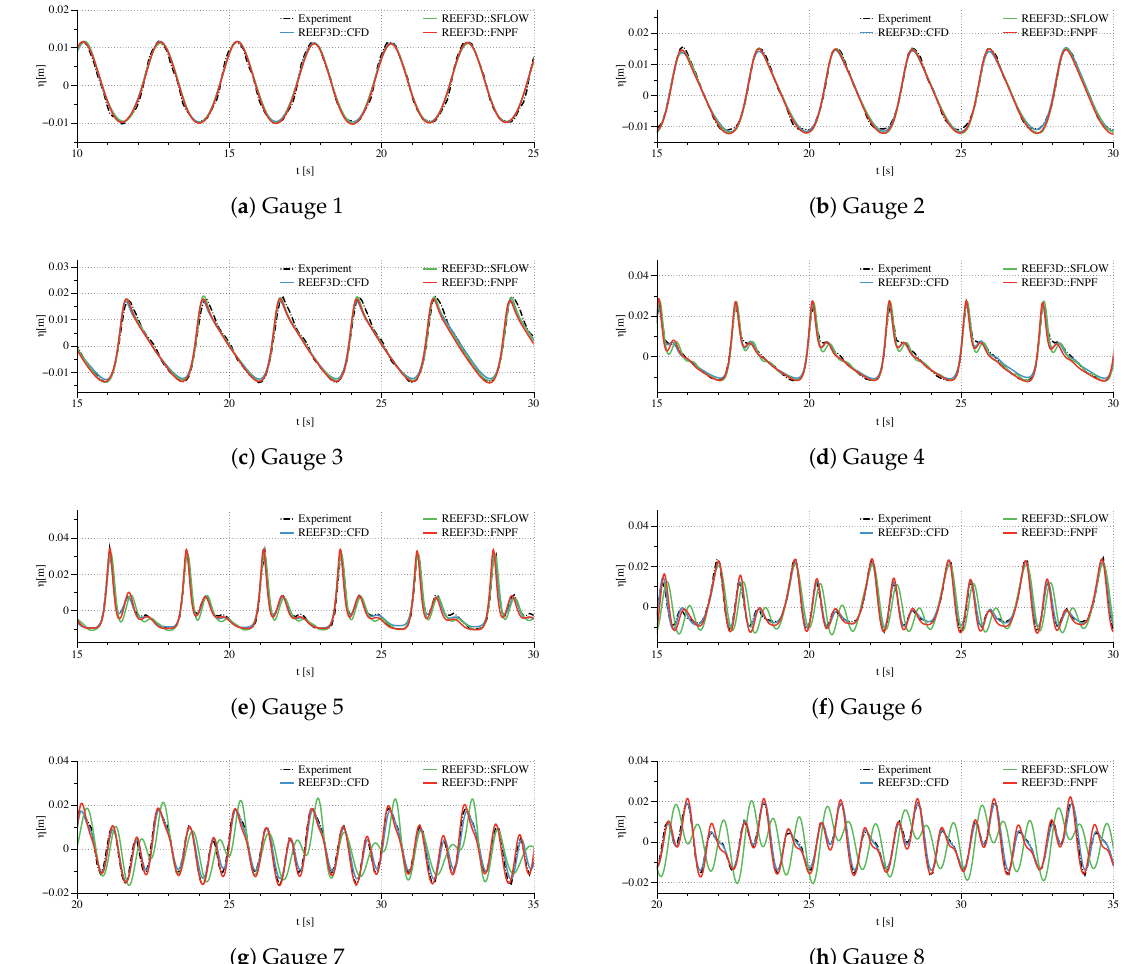
Figure 5. Comparison of the time histories of the free surface elevations at the wave gauges in the simulations of wave propagation over a submerged bar using the cell sizes achieving grid convergence.